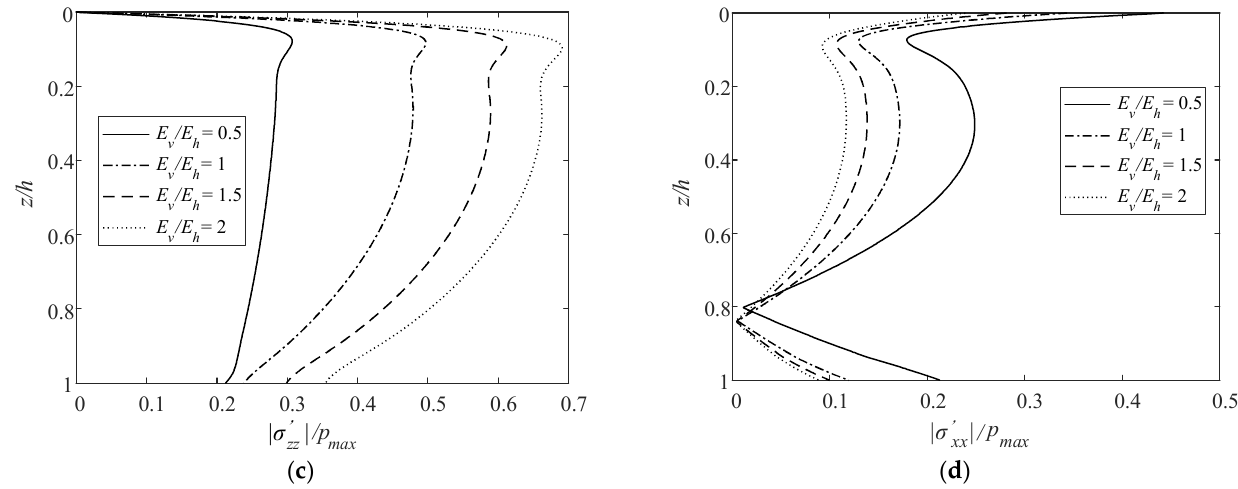
Figure 11. Vertical distribution of normalized maximum ( a ) pore pressure, ( b ) shear stress, ( c ) vertical effective stress, and ( d ) horizontal effective stress by varying E v / E h . Figure 12 denotes z max versus E v / E h for various S r , T , n , and U 0 . On the contrary to the effect of K v / K h , z max increases with E v / E h , showing the tendency of more severe liquefaction. For the same E v / E h , z max increases with decreasing S r and T but increasing n . Similar to the effect of K v / K h , the following current aggravates the liquefaction depth whilst the opposing current alleviates the liquefaction depth. It is obvious that even though | U 0 | is equal, the direction of the current can lead to varying degrees of change in z max . Besides, if the seabed is regarded as isotropic, z max would be underestimated when E v / E h > 1 but overestimated when E v / E h < 1.